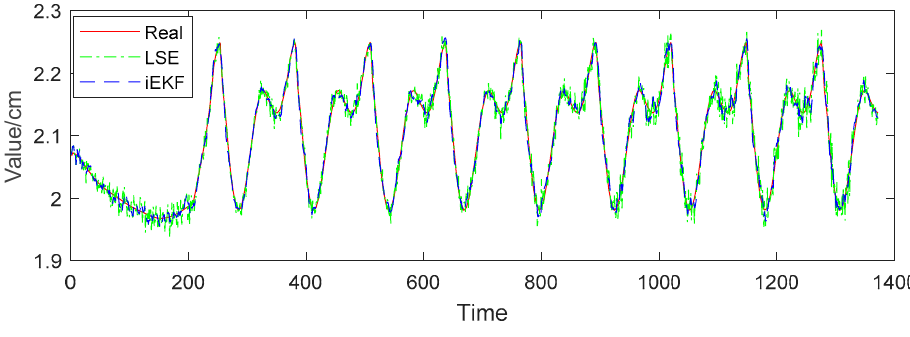
Figure 9. Comparison of two algorithms for θ heart - lshoulder - lelbow .